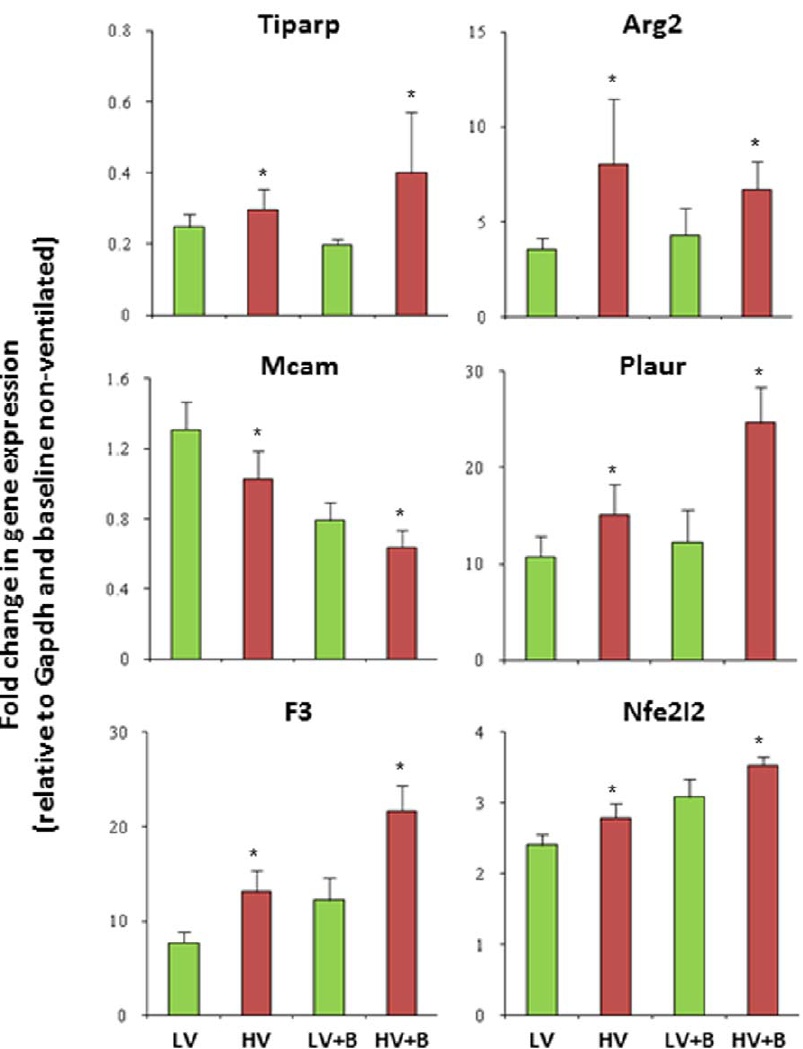
Figure 6. Validation of the genes used in the prediction model by qRT-PCR. qRT-PCR of selected genes. The gene expression was normalized against GAPDH. The changes in gene expression are expressed as fold change relative to GAPDH and the baseline sample from non- ventilation samples. Data are presented as means 6 SEMs (n=3), * p , 0.05 between non-ventilated and ventilated groups. TCDD-inducible poly(ADP- ribose) polymerase (Tiparp); arginase, type II (Arg2), melanoma cell adhesion molecule (Mcam), plasminogen activator, urokinase receptor (Plaur), coagulation factor III (F3, thromboplastin, tissue factor), and nuclear factor, erythroid derived 2, like 2 (Nfe2l2).